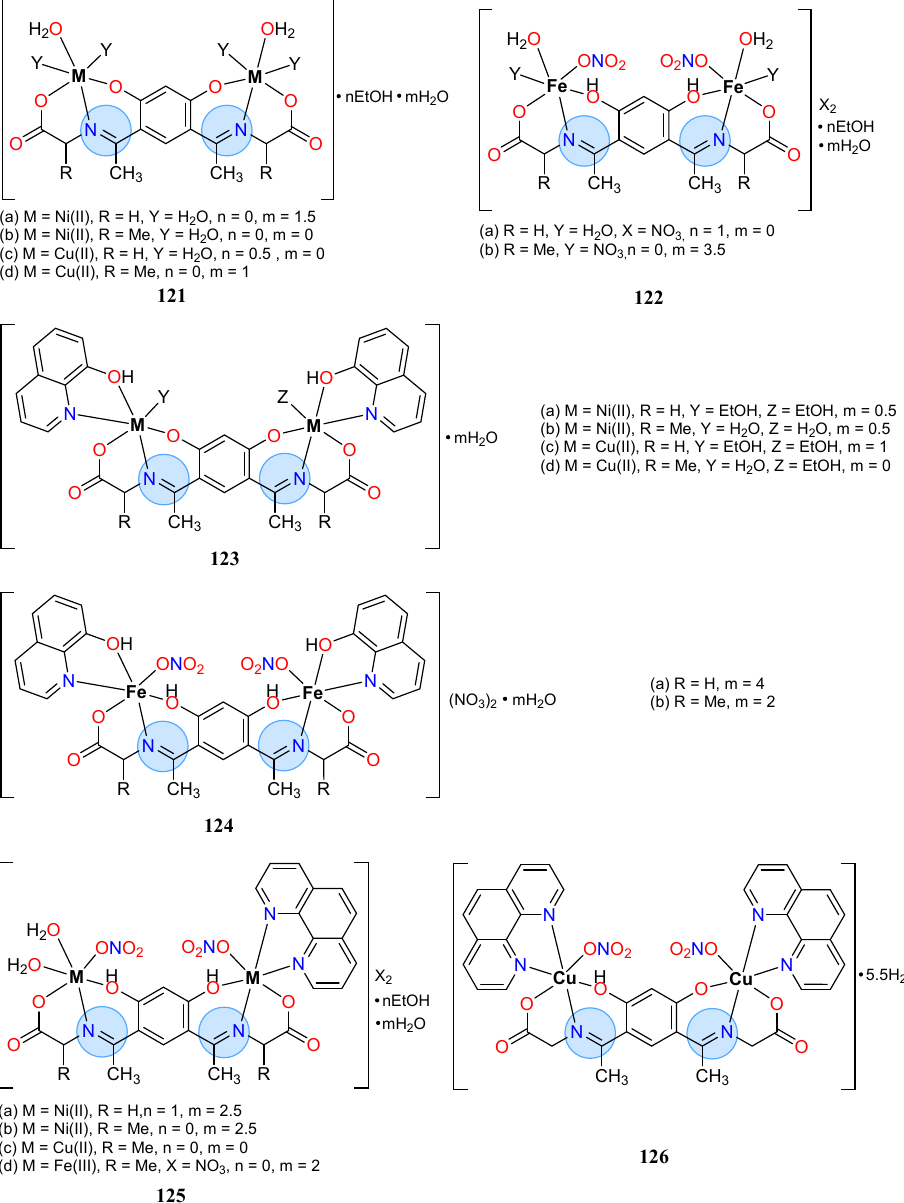
Figure 63. Representative structures of binuclear Ni(II), Cu(II), and Fe(III) complexes derived from Schiff bases with 8 ‐ hydroxyquinoline (8 ‐ HQ) or 1,10 ‐ phenanthroline (Phen) as secondary ligands.